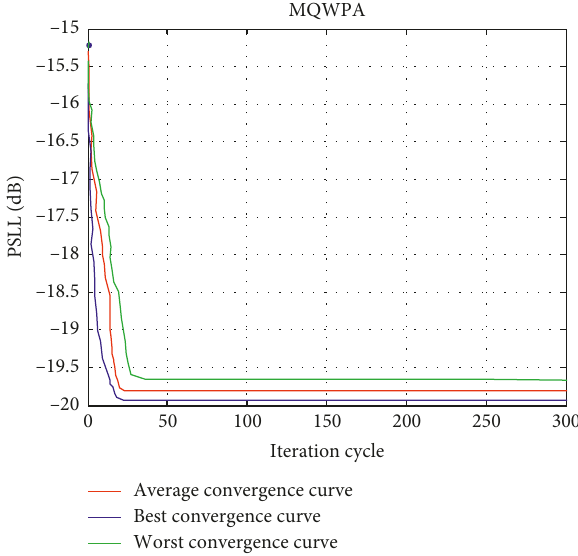
Figure 6: Convergence curve of fitness function. MQWPA for Example 1